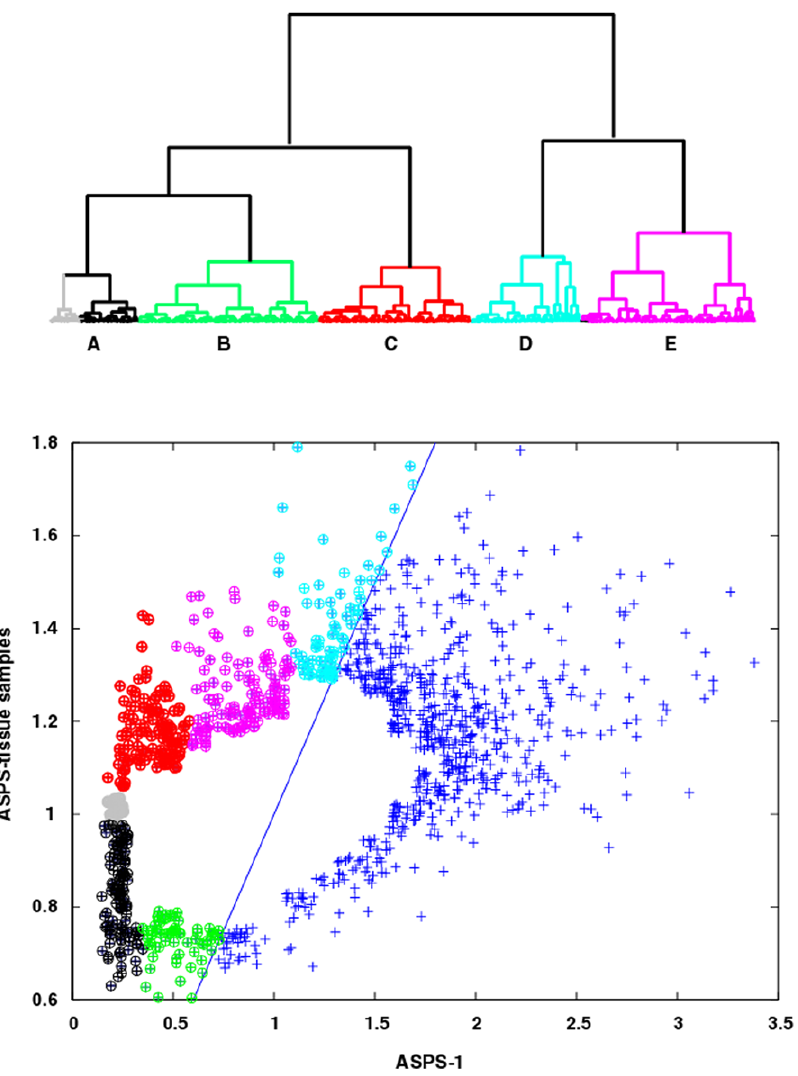
Figure 3. Top Panel; Dendrogram for pooled ASPS-tissue Gene Expressions. Clades are colored to identify samples associated with five meta-clades (DEND meta-clades A, B, C, D and E). The members of DEND meta-clade A with ASPS-tissue values higher than universal RNA are displayed in gray. All other meta-clades are comprised of genes with expression values above universal RNA (i.e. values above 1.0 on the y-axis). Bottom Panel, ASPS-tissue versus ASPS-1 scatter plot where cluster memberships are color-coded to match the meta-clade dendrogram displayed in top panel.